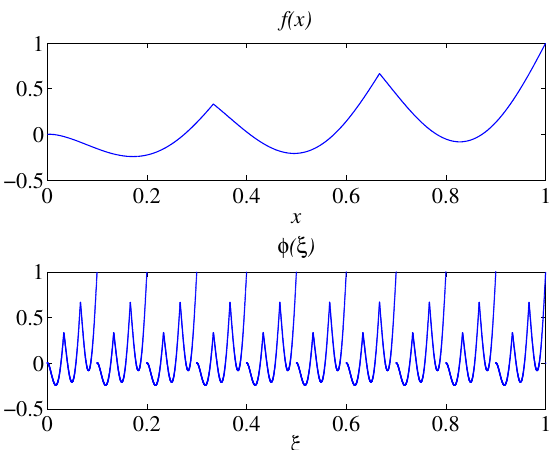
|√ x sin ( 3 π x ) | with three local minima in the unit